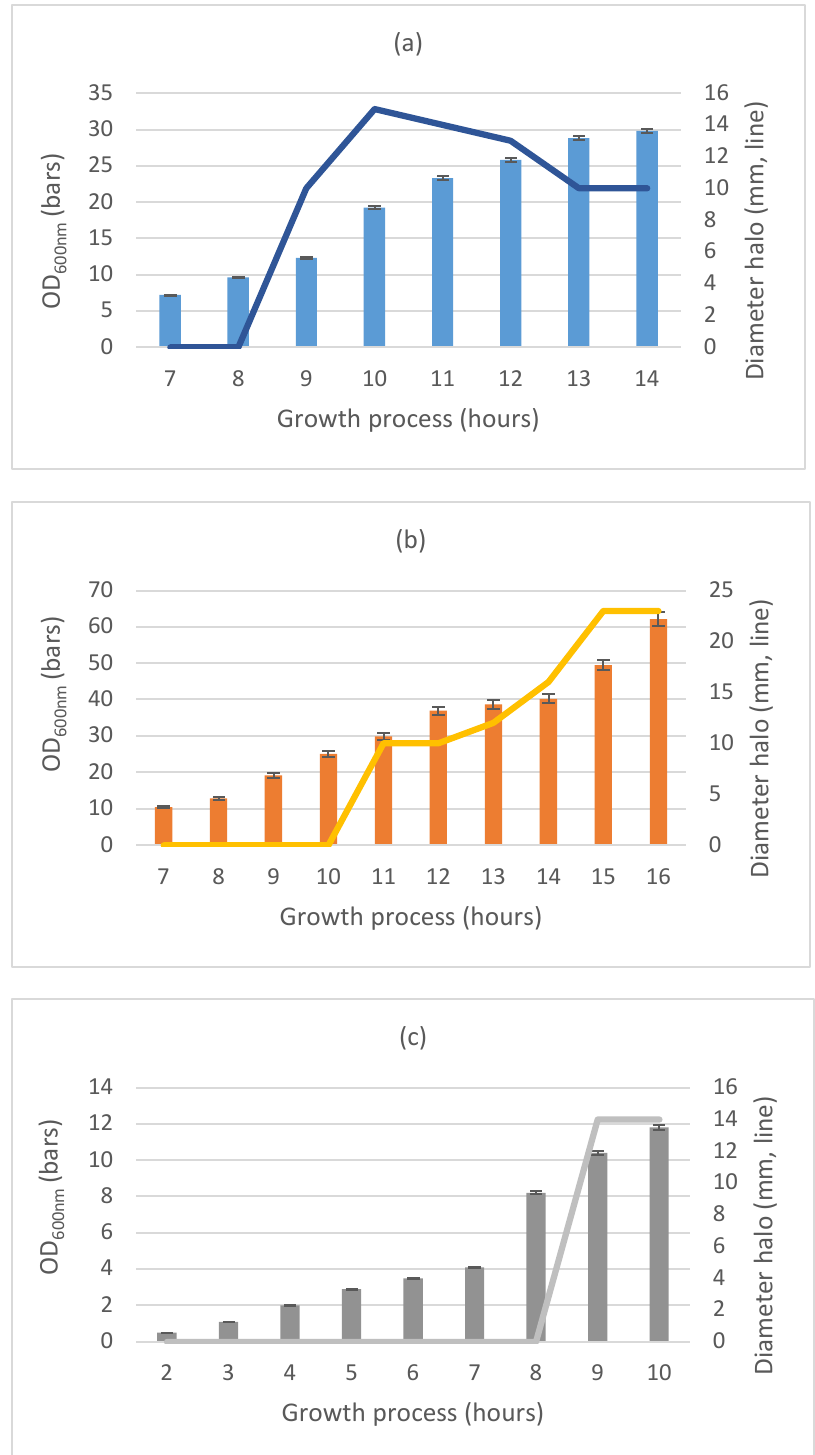
Figure 1. Ki netics of growth and killer toxin activity of ( a ) Wickerhamomyces anomalus DiSVA2, ( b ) Kluyveromyces wickerhamii DiSVA15 and ( c ) Wickerhamomyces anomalus DiSVA671, tested against Brettanomyces bruxellensis sensitive strain. Growth was measured as OD600 nm, toxin production was evaluated as size of the inhibition halo (in mm, considered 8 mm the wall diameter) in well test assays. Colored bars ( ), ( ), ( ) indicate values of OD600 nm for W. anomalus DiSVA2, K. wickerhamii DiSVA15 and W. anomalus DiSVA671. Similarly, lines ( ), ( ), ( ) indicate the values of diameter. Microbial growth (bars) was reported as mean values ± standard